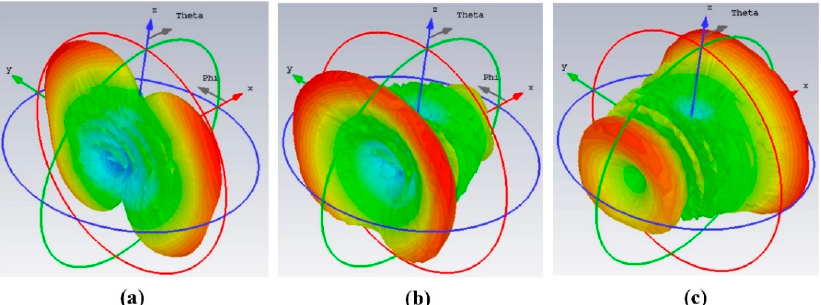
Figure 10. The simulated 3D radiation beams of the array at different scanning angles. ( a ) 0 degree; ( 2 ) 30 degree; ( c ) 60 degree.